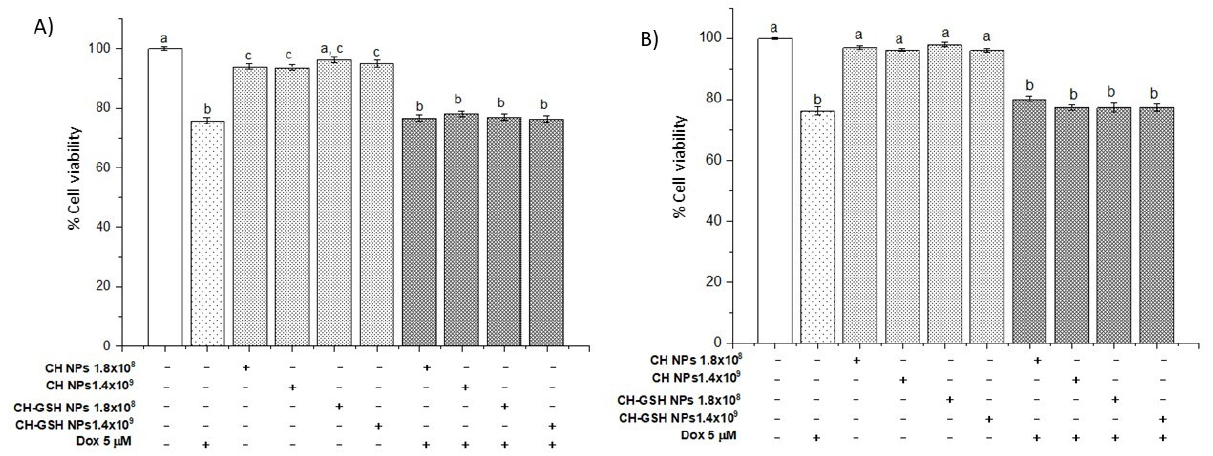
Figure 3. Viability of cells exposed to doxorubicin for 12 h and then 2 h with NPs. (A) MCF-7 and (B) MDA MB-231 cells. Bars with equal letters indicate no significant differences between the means (Tukey’s test, p <0.05).